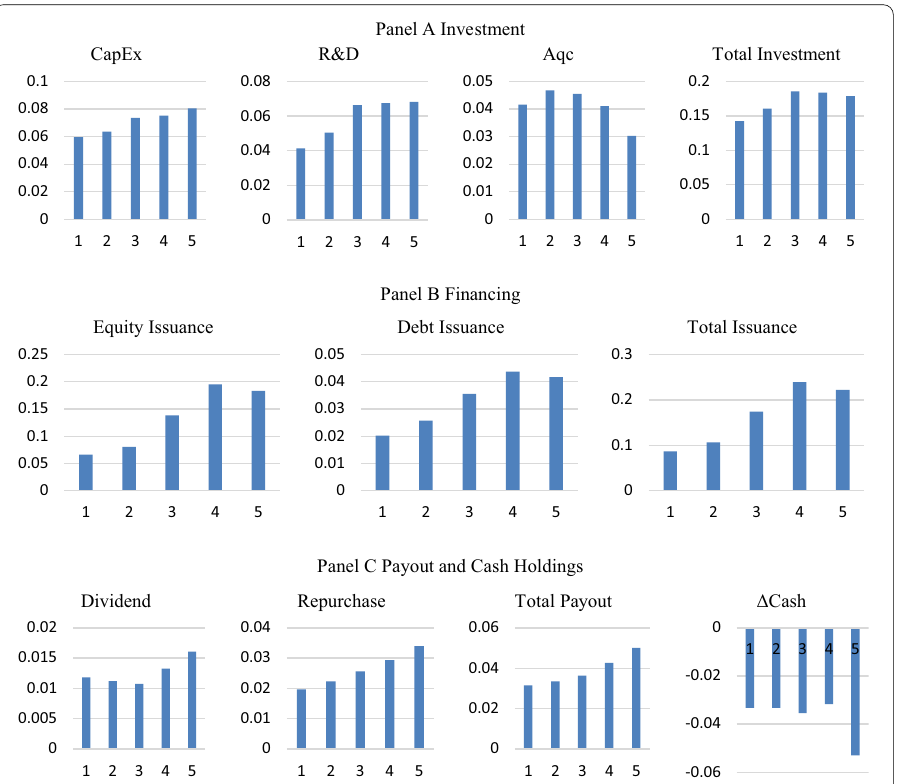
Fig. 1 Corporate policies in options trading quintiles. This figure presents the mean value of each capital police measure employed in this study over all sample years within each quintile of options trading volume. Observations are assigned into the quintiles based on options trading volume on each year, where quintile 1 contains observations with the lowest option trading volume and quintile 5 captures observations with the highest option trading